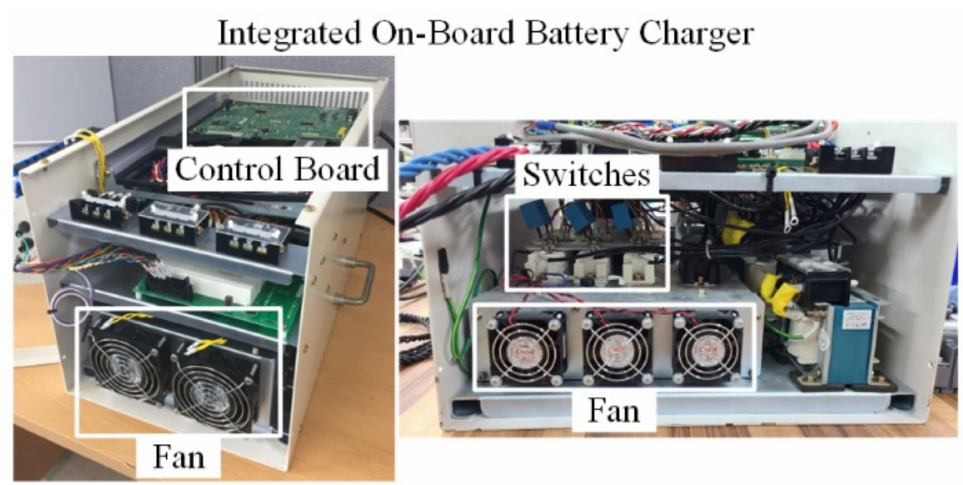
Figure 13. Experimental